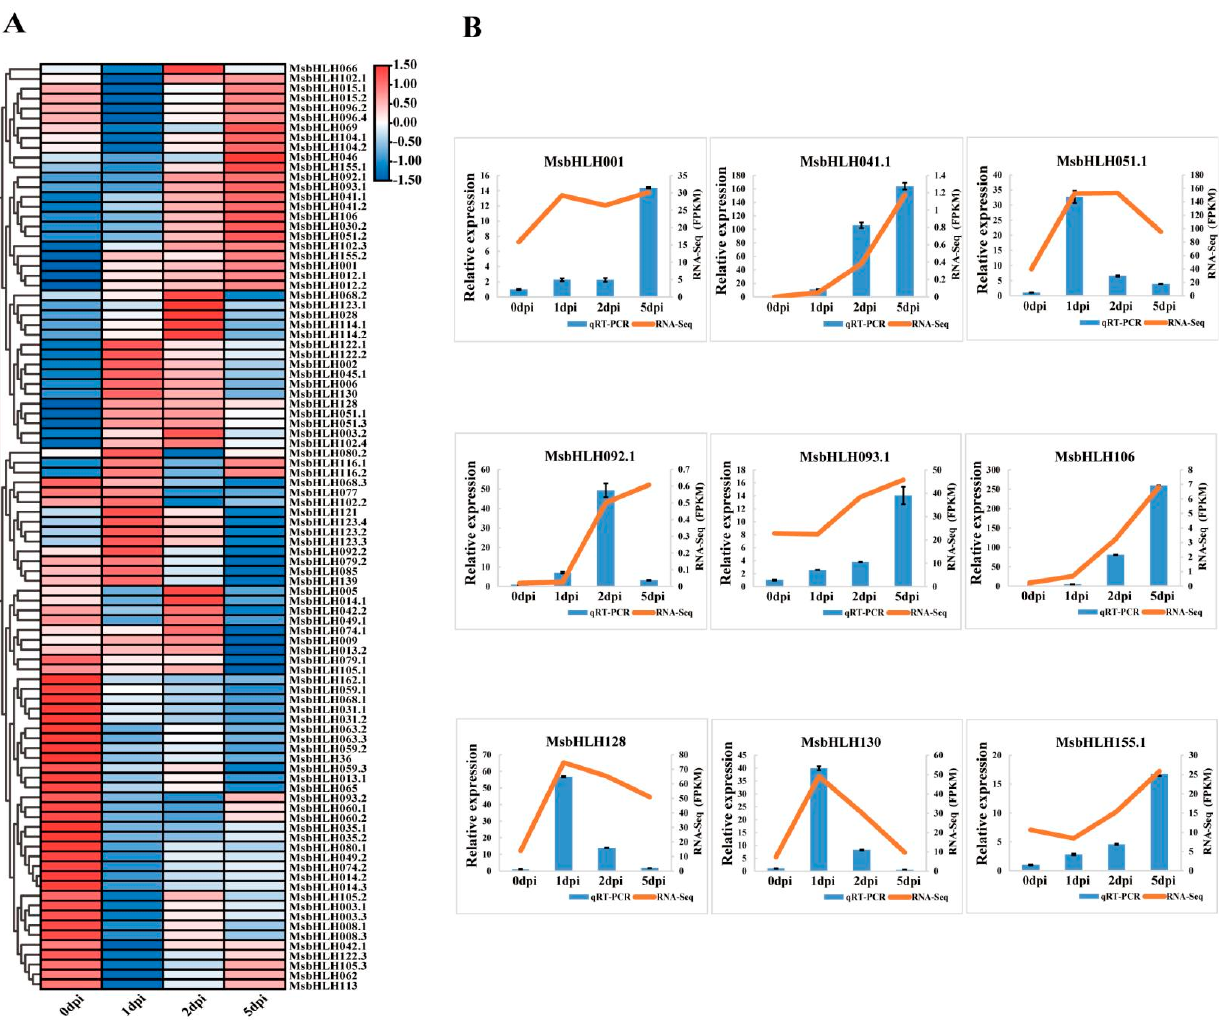
Figure 7. Expression analysis of DEG MsbHLHs upon V. mali infection at 0, 1, 2, 5 dpi. ( A ) Clustering expression analysis of 94 MsbHLH genes under V. mali infection based on transcriptome data by Illumina sequencing [42]. The color scale represents the fragments per kilobase million (FPKM) value after the V. mali infection. The values were normalized for the significant expression genes by more than 1.0 fold. Red and blue indicated high and low expression levels, respectively. ( B ) Relative expression analysis of nine MsbHLH genes detected by qRT-PCR. The blue column represents the FPKM values. The orange line represents the relative expression level expression profiles of the 9 MsbHLH genes responding to Valsa canker